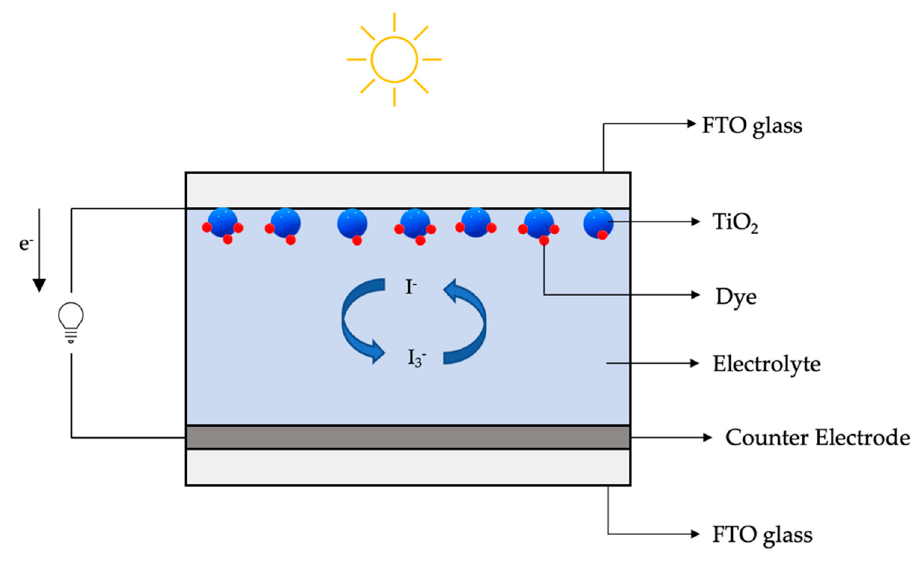
Figure 1. Schematic diagram of a dye sensitized solar